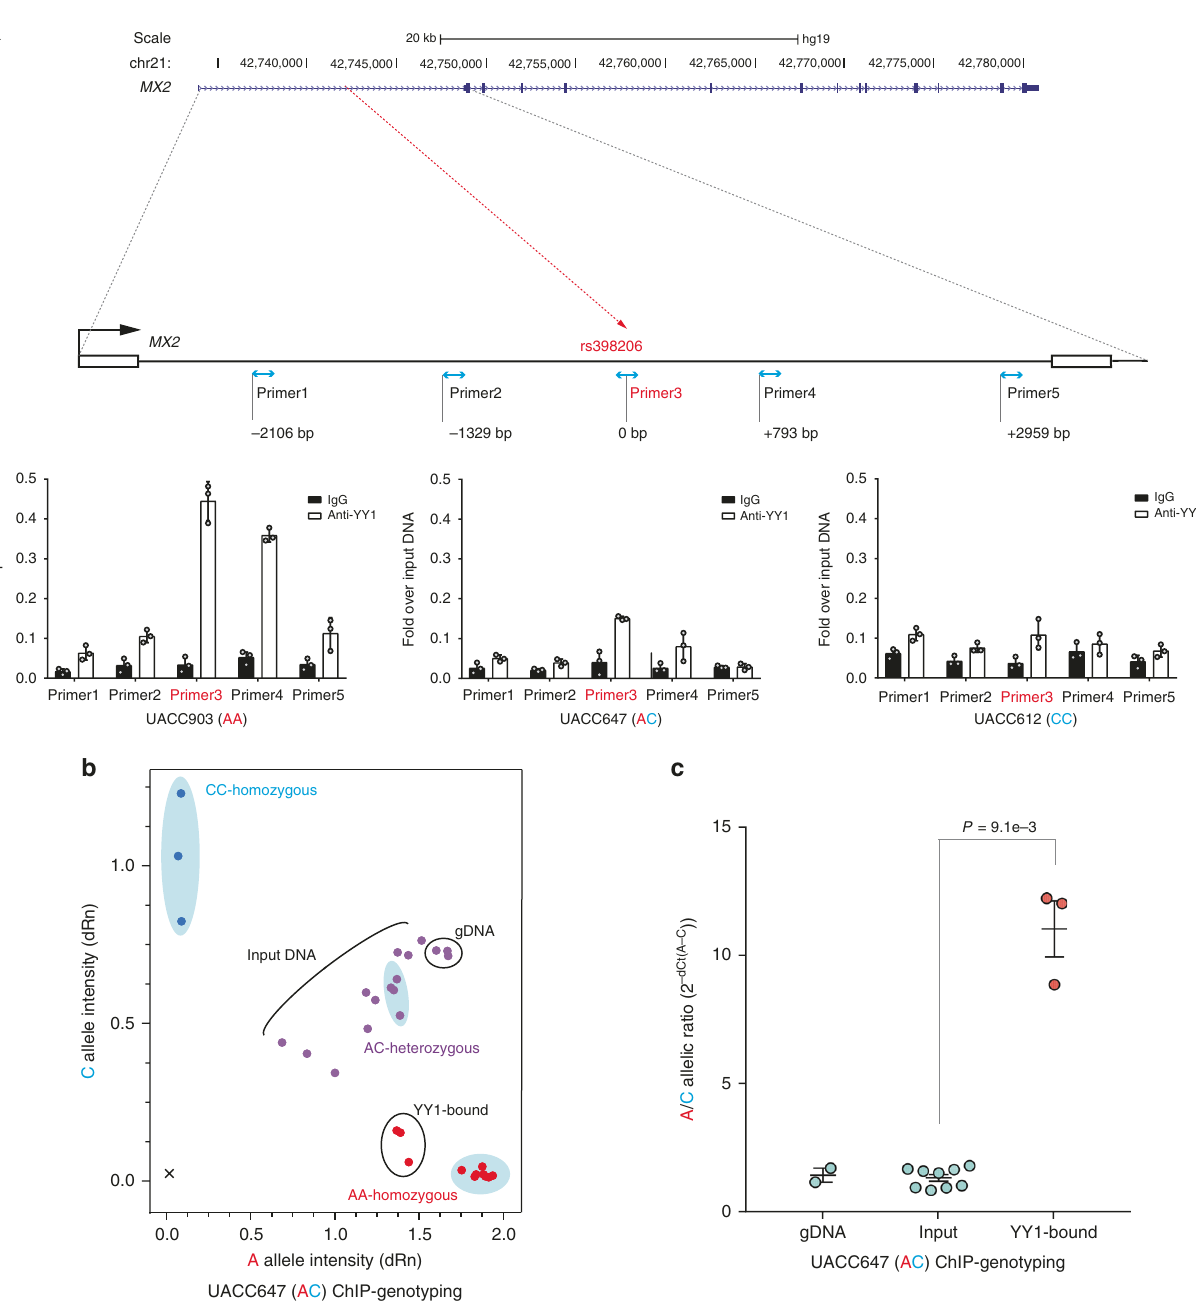
Fig. 4 YY1 preferentially binds to the rs398206-A allele in melanoma cells. a Chromatin immunoprecipitation using anti-YY1 antibody or normal IgG followed by qPCR. On the top panel, genomic positions of the amplicons using fi ve qPCR primer sets are shown relative to rs398206 (red dashed line) in the fi rst intron of MX2 . qPCR results from three melanoma cell lines are shown on the bottom panel with genotype for rs398206 indicated in the X -axis label. Relative quantities are shown as fold over input DNA. Mean of PCR triplicates with SD are plotted. One representative set of three biological replicates for each cell line is shown. b Taqman genotyping of rs398206 using YY1 ChIP DNA in UACC647 melanoma cells (heterozygous for rs398206). The blue shaded areas mark HapMap CEU DNA controls showing separation of three genotype clusters. qPCR triplicates were plotted separately. One representative set from three biological replicates is shown. Normalized A and C allele intensity is shown as dRn values on x and y -axis, respectively. gDNA: genomic DNA. c Combined plot for A/C allelic ratio from three rounds of biological replicates of UACC647. Each dot represents A/C ratio calculated from 2 -(average dCt(alleleA-alleleC)) from qPCR triplicates. Input includes three 10-fold serial dilutions from each round. Mean with SEM are plotted. A